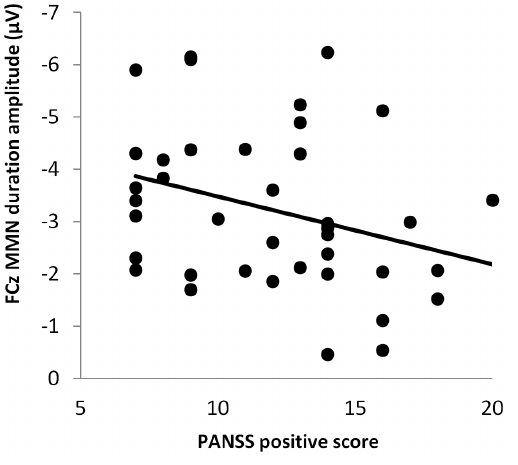
Figure 5. Positive symptom scores and MMN amplitude. Scatterplot of PANSS positive symptoms against MMN amplitude to duration deviants at FCz.